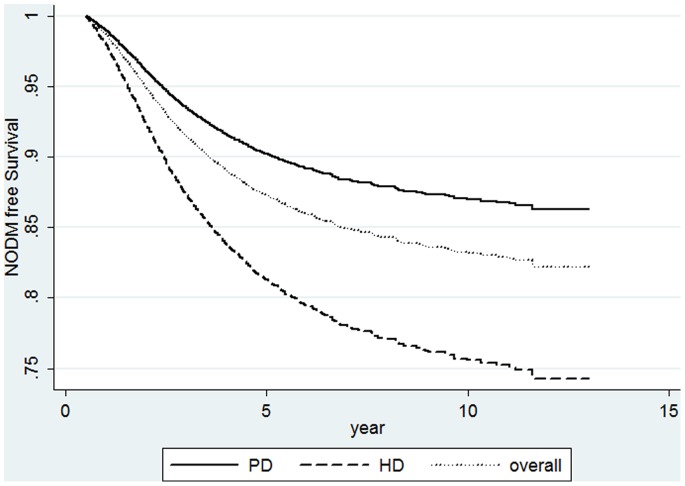
A new-onset diabetes free survival curves of hemodialysis (HD), peritoneal dialysis (PD), and all patients with adjustments for patients’ age, gender, hypertension, hematocrit and serum albumin.